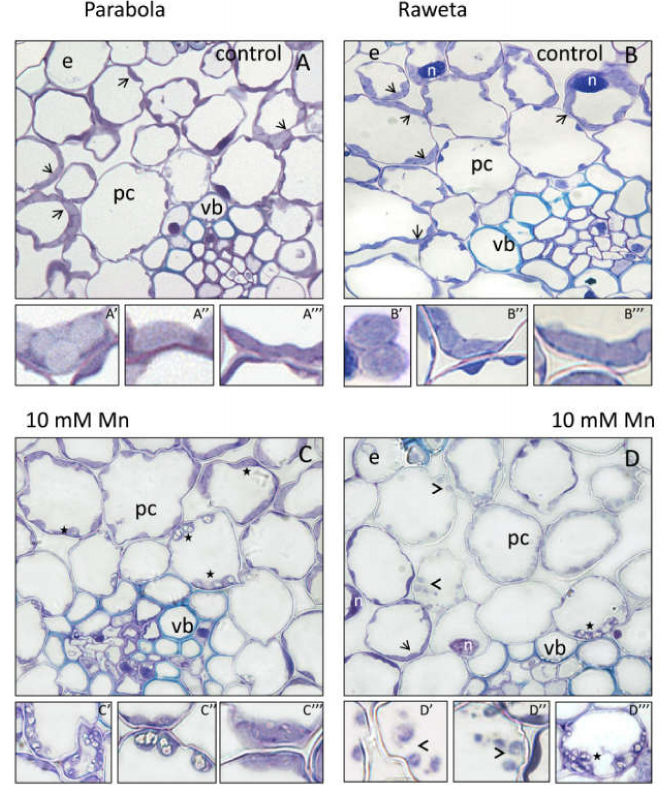
Figure 5. Example of leaf sections of Parabola and Raweta, in control and at 10 mM MnCl 2 . Inset shows magnified fragment with proplastides—marked by arrow and starch granules—marked by a star. Pc-parenchymatic cell, vb-vascular bundle, n-nucleus, e-epidermis. For ( A – D ) magnification was 40 × ; for inset 100 ×